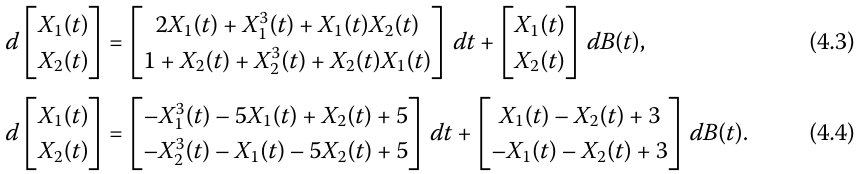
Example 4.2 Consider a two-dimensional